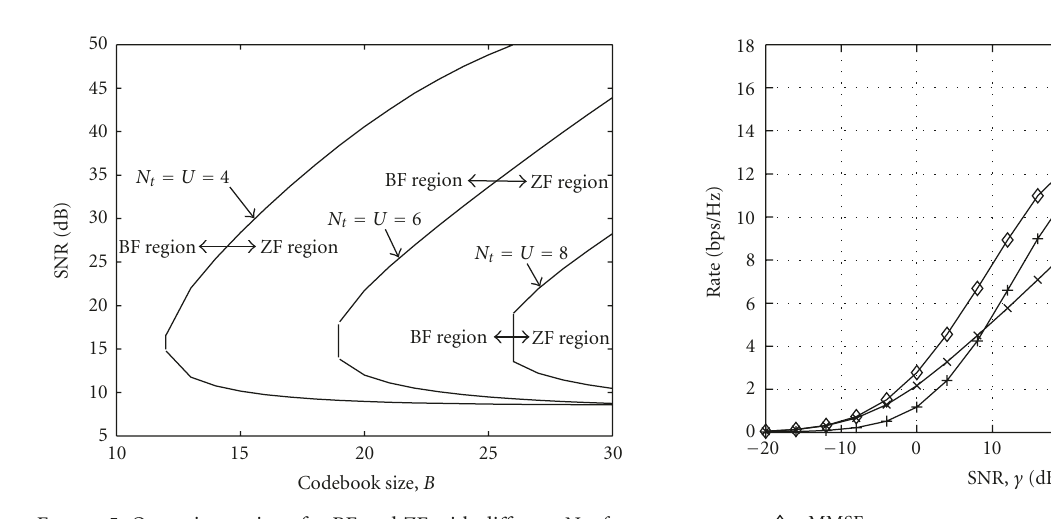
Figure 5: Operating regions for BF and ZF with di ff erent N t , f c = 2GHz, v = 10km/hr, T s = 1 msec.